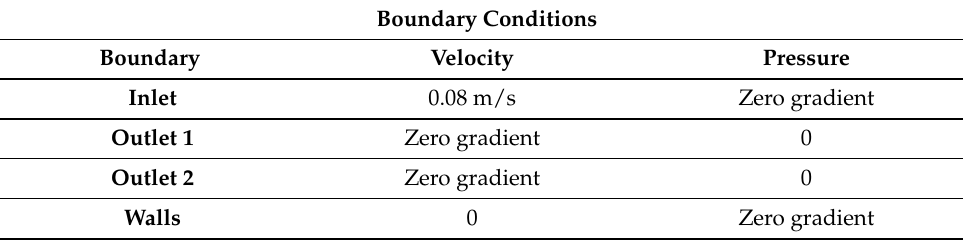
Table 2. Boundary conditions.